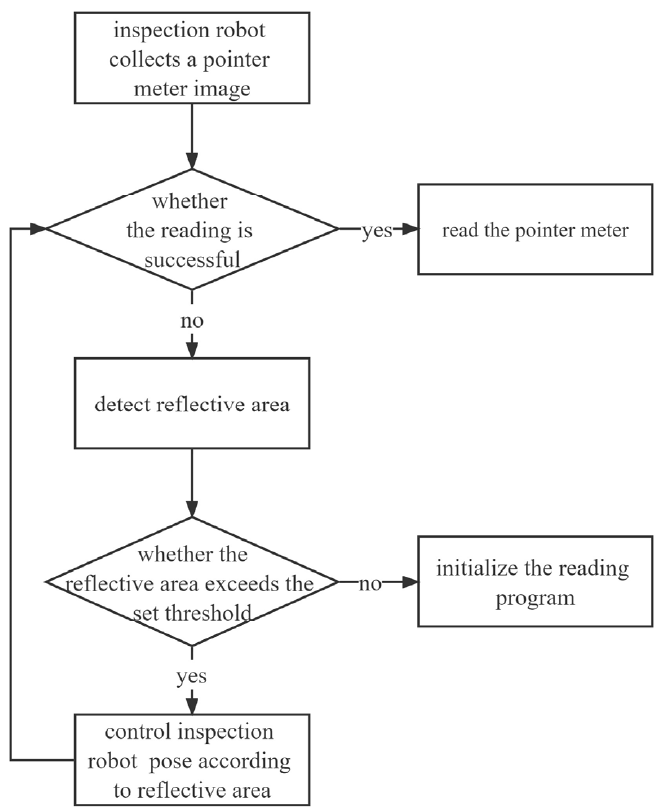
Figure 17. Flow chart of pointer meter detection and recognition.